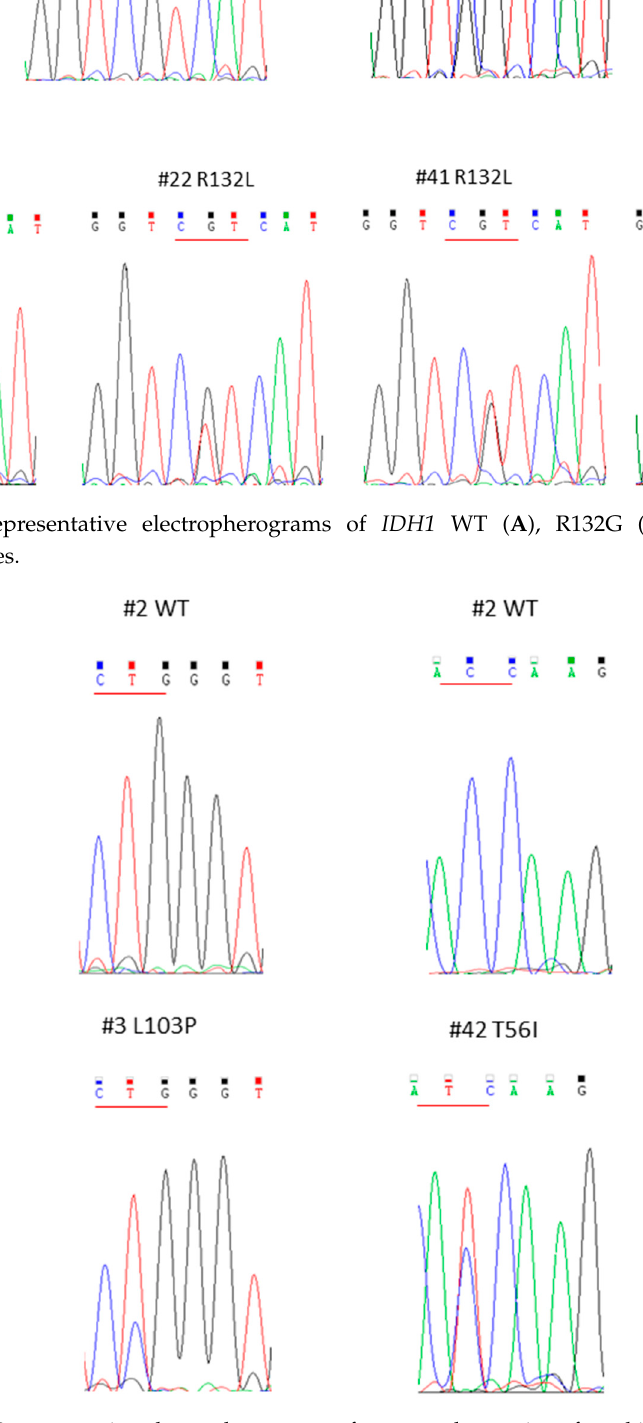
Figure 5. Representative electropherograms of two novel mutations found in IDH1 exon 4.